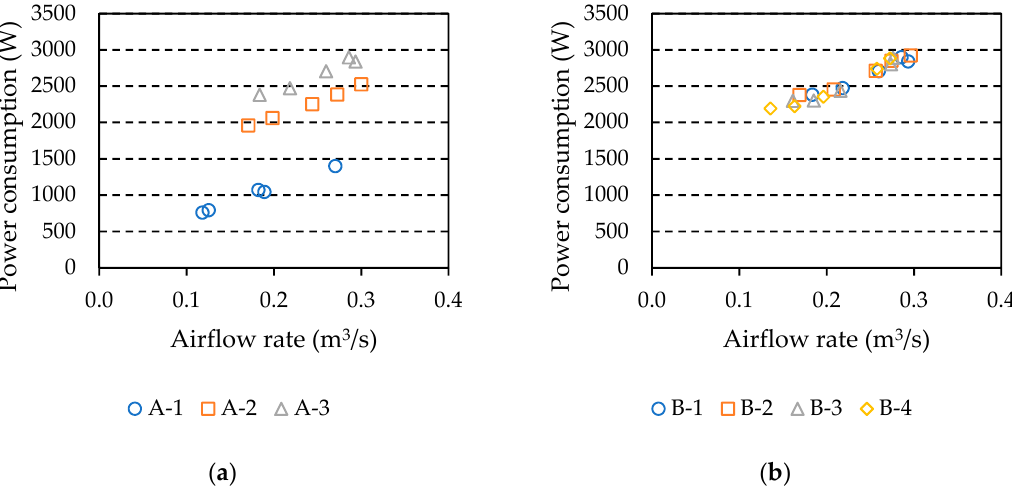
Figure 8. Relationship between total airflow rate and total power consumption of 12 servers (experiments A and B): ( a ) Results of experiment A, ( b ) results of experiment B.